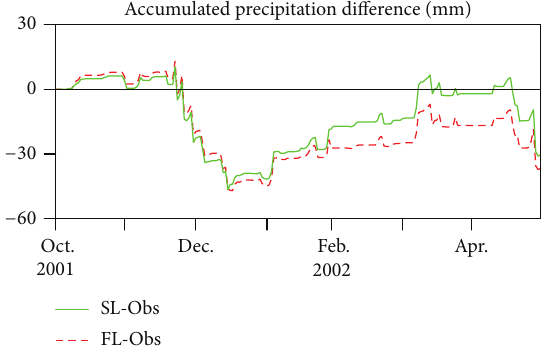
Figure 4: Accumulated daily precipitation difference between SL (FL) and observations at Garfield station from October 2001 to April